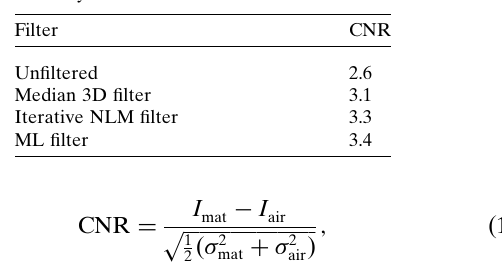
Table 1 Calculated contrast-to-noise ratio (CNR) for a region of interest (3rd row in Fig. 4) in a butterfly scale.